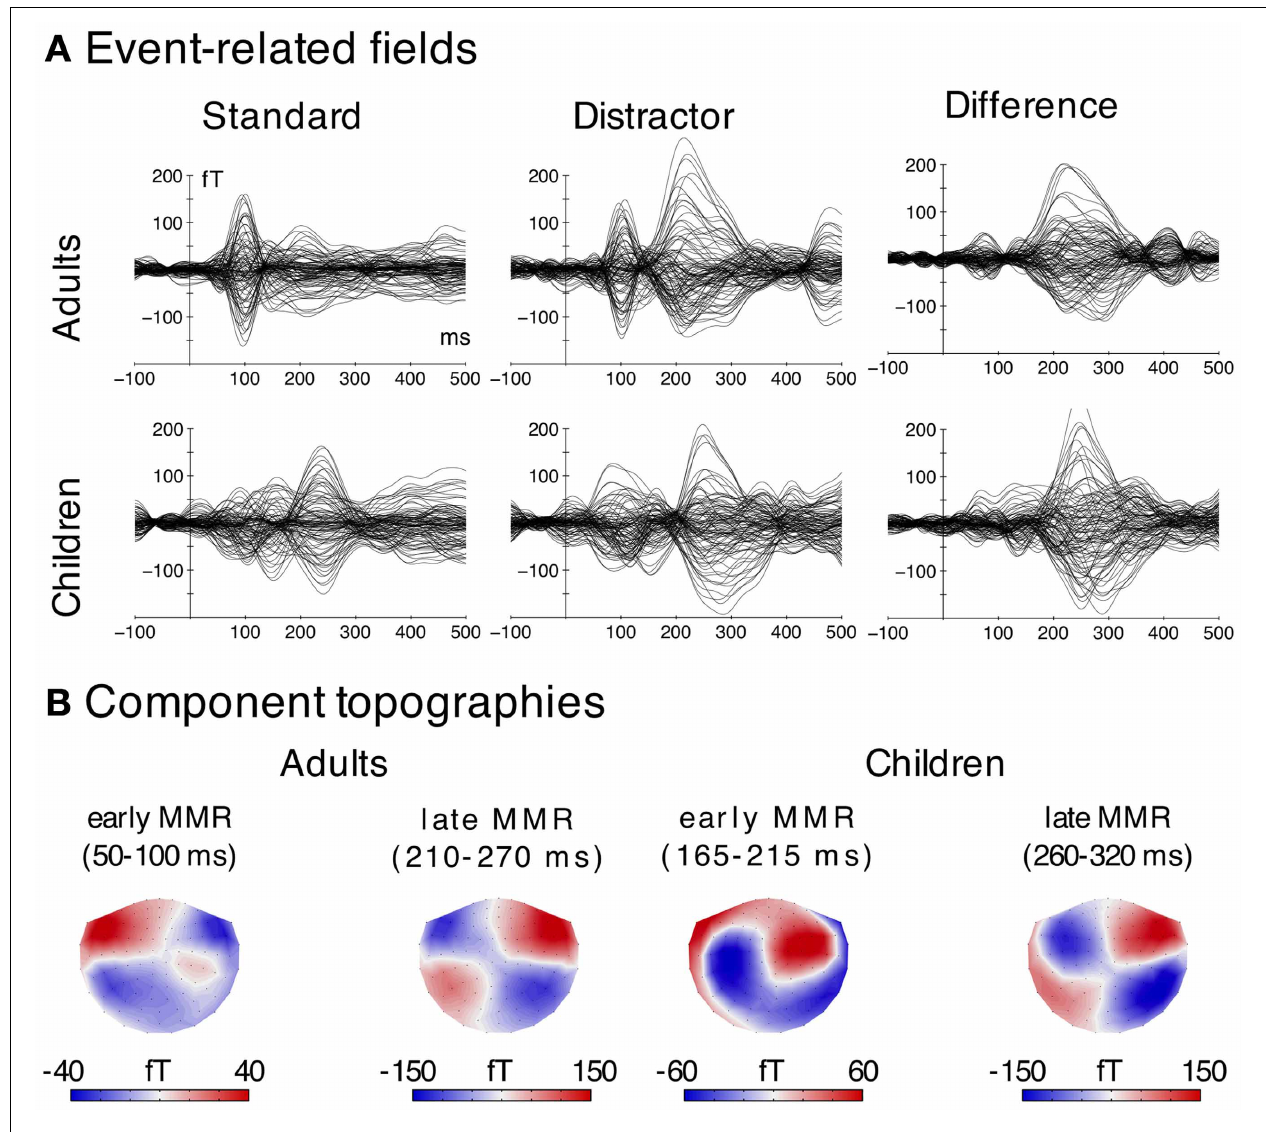
FIGURE 3 | MEG data. (A) Grand average ERFs elicited by the two stimulus types (distractor; standard) and difference wave (distractor-minus-standard). Time courses for each sensor (magnetometer) are displayed. (B) Magnetic